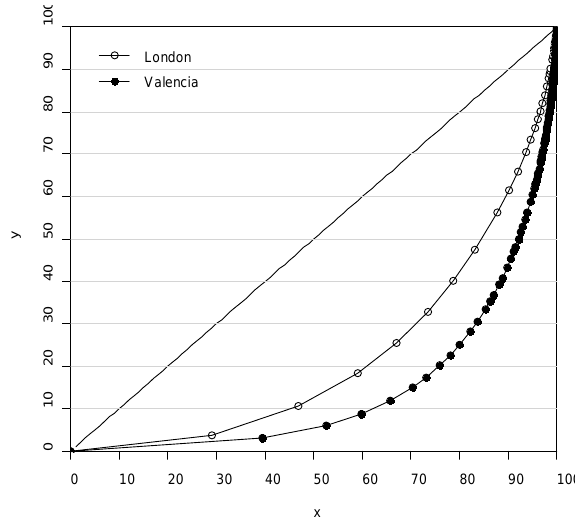
Figure 2. Concentration curves for London and Valencia (1971–2010). These curves are Fig. 2. Empirical and fitted concentration curves for London and polygonal lines based from empirical values (black and white circles). X values represents the Valencia accumulated percentage of number of rainy days and Y values are the correspondent accumulated percentages of precipitation. The bisector of the quadrant is the equidistribution line where the precipitation amount is equal and constant for each precipitation class.